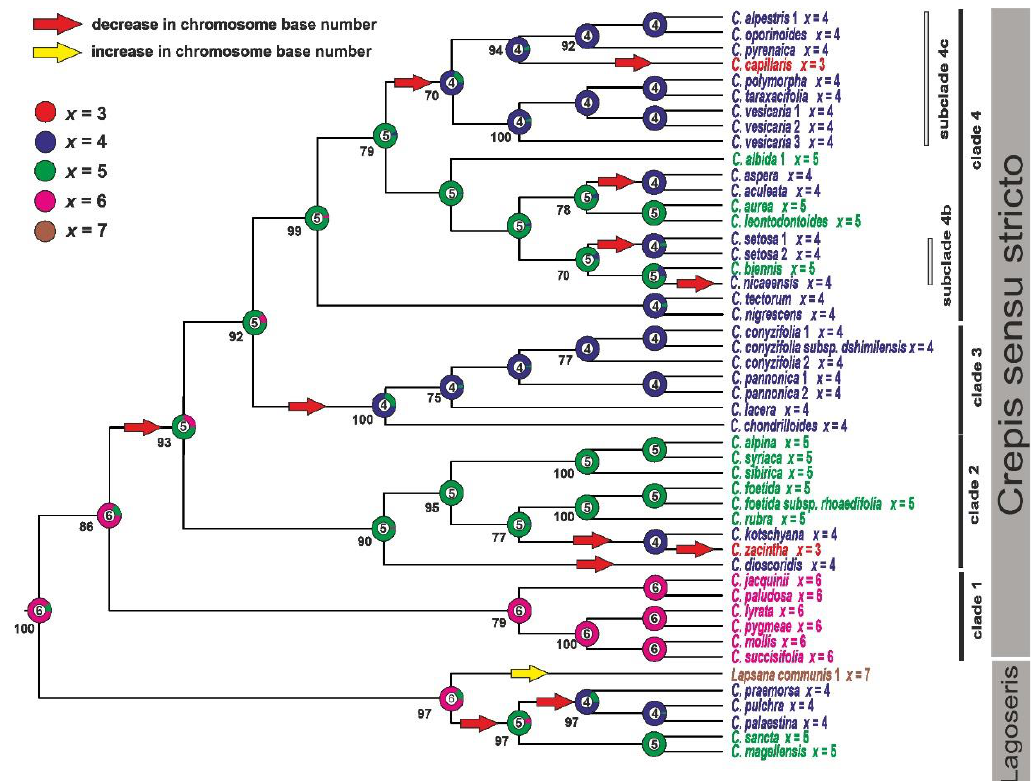
Figure 3. Ancestral character state reconstruction of the chromosome base numbers in Crepis s.l. The chromosome base numbers have been mapped on the ML tree resulting from analyses of the nrITS sequences using the maximum likelihood method as implemented in ChromEvol 2.0. The tree was rooted with Picris hieracioides , Lactuca serriola and Sonchus oleraceus. Bootstrap scores are shown below the branches.